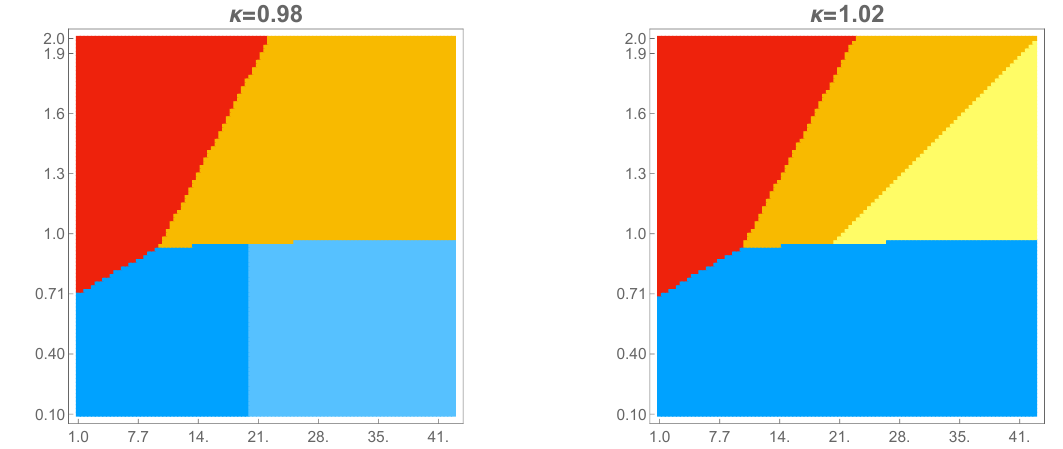
Figure 12 . Phase diagrams for intermediate-tension walls exhibiting sweeping transitions. On the left a restpoint of the vacuum solution is swept away as γ increases beyond a critical value. On the right the same happens in the warm solution but for decreasing γ . In these diagrams, the one-center warm solution is always